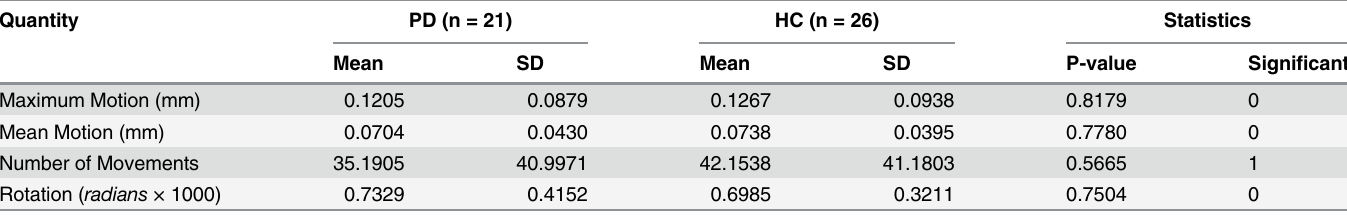
Table 2. Head motion